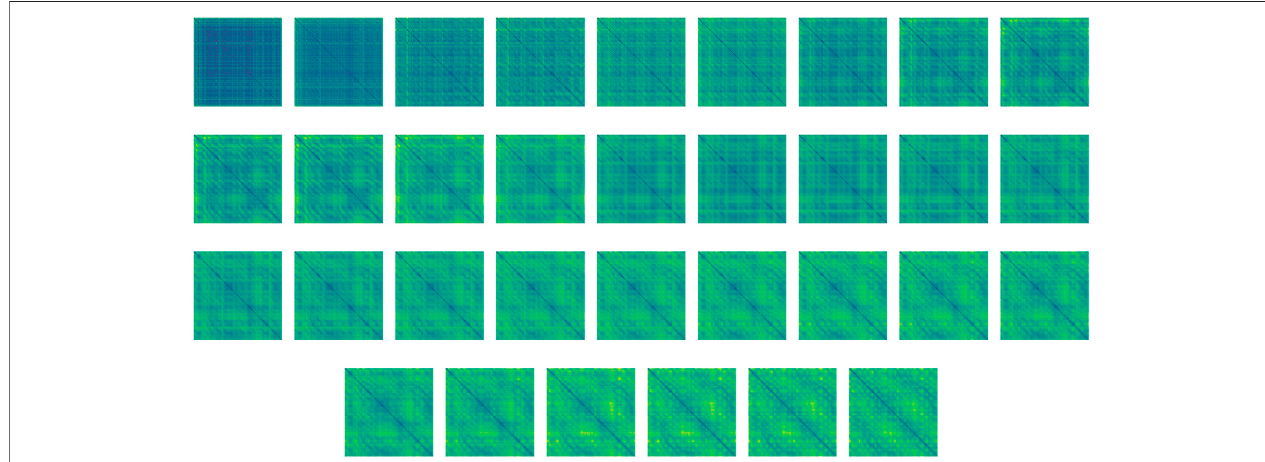
FIGURE 4| Distance maps of the high-dimensional featureevolution from unstructured (top left) to structured (bottom right) throughout the bi-directional network, duringstructurepredictionofT0783.Forabetterdemonstrationoftheprocesssmoothness,thenetworkincludes32layersinsteadofthesixlayersusedthroughoutthe numerical study. Step size was adjusted to match the integration time. The idea of layer interpolation is discussed in Ruthotto and Haber (2019); Chen et al. (2018); Han et al.